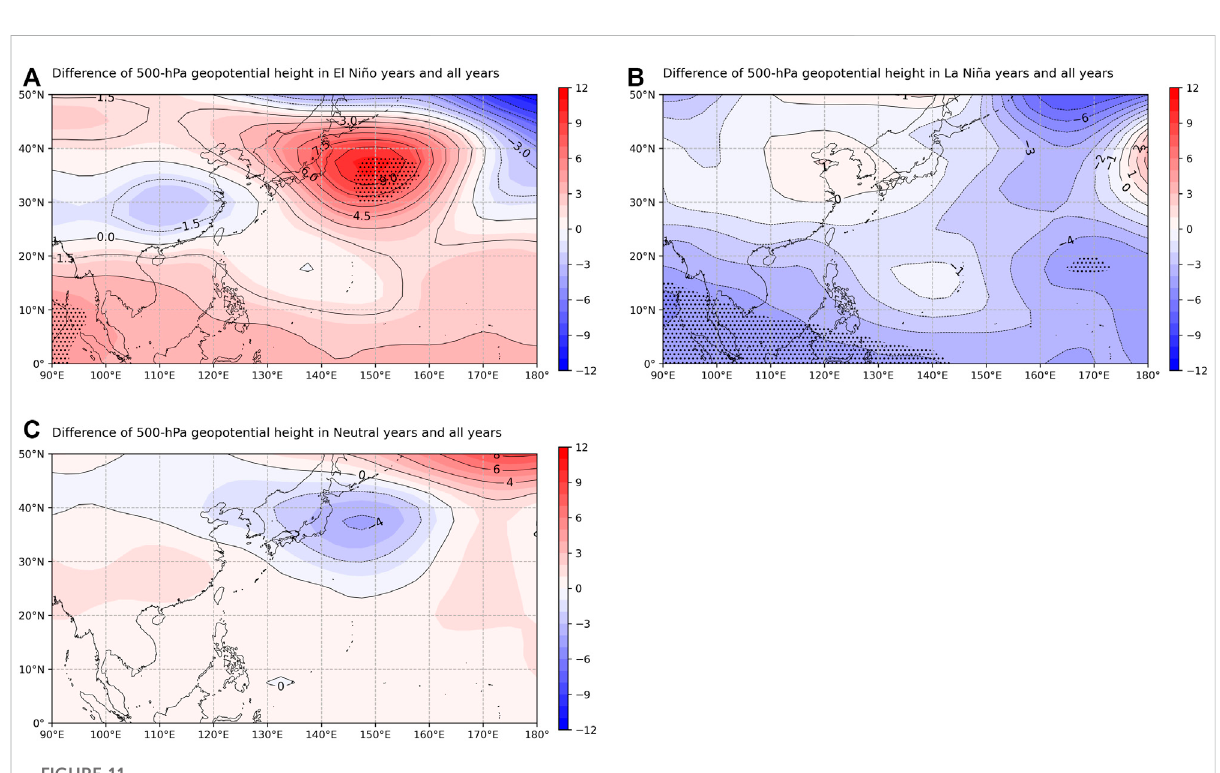
FIGURE 11 Same as Figure 8, but for 500-hPa geopotential